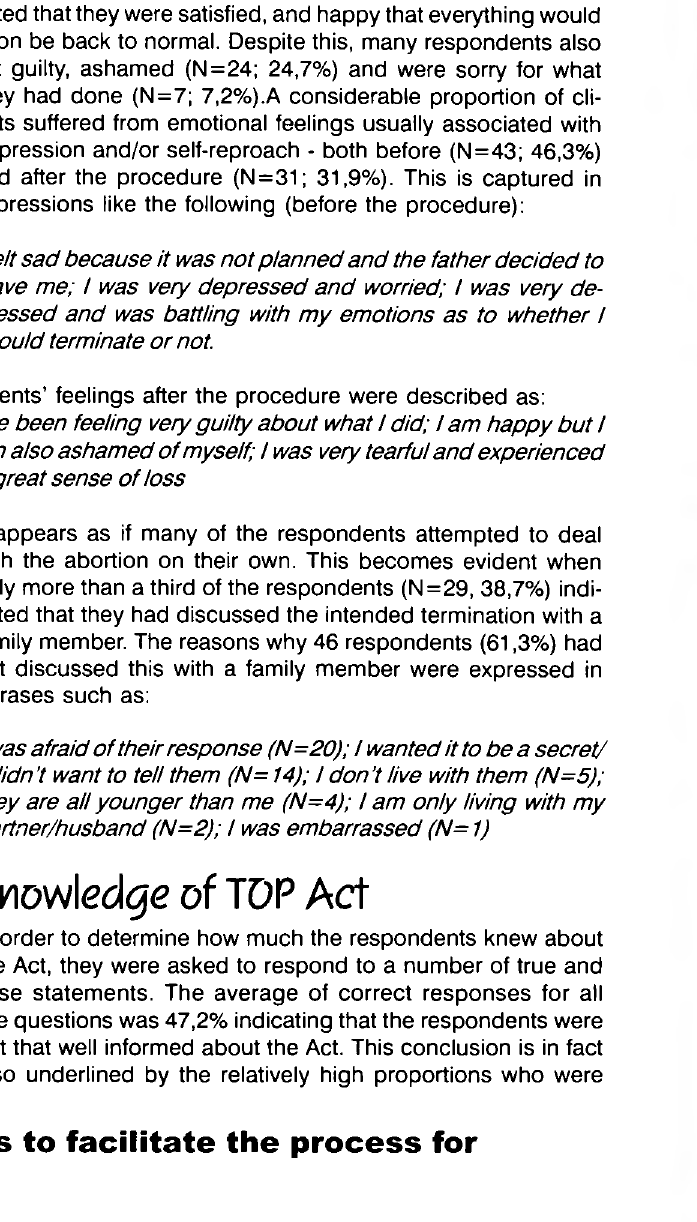
Table 3 : Respondents’ recom m endations to fa c ilita te th e process for w om en considering TOP